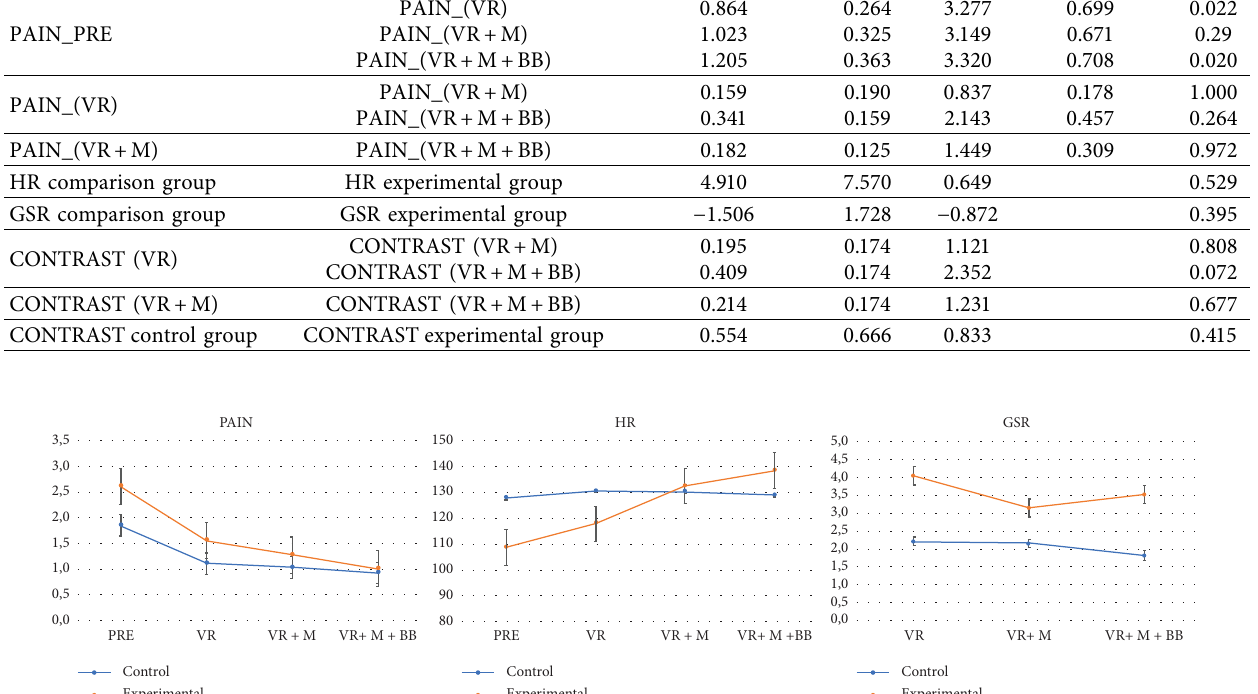
Figure 2: Graphic representation of the descriptive analysis of the three study variables. Te horizontal axis shows each of the sessions and the vertical axis shows the mean value in the units belonging to each variable. It is observed that as elements are added to the RV (the M and BBs), pain perception, and GSR decrease, contrary to the